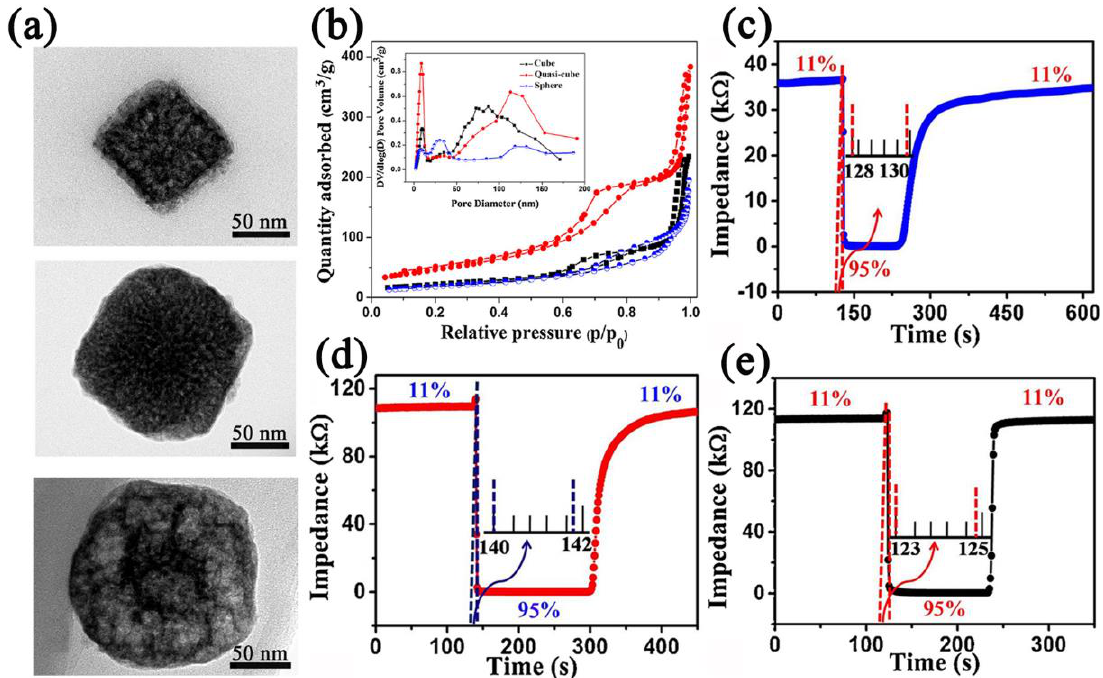
Figure 8. ( a ) TEM images of PB − derived Fe 2 O 3 nanostructures with different morphologies. ( b ) N 2 adsorption − desorption isotherms and corresponding pore size of different morphologies of Fe 2 O 3 nanostructures. Response and recovery curves of different morphologies of Fe 2 O 3 − based humidity sensors between 11% RH and 95% RH ( c ) cubes, ( d ) quasi − cubes, and ( e ) spheres. Reproduced with permission from Ref. [88]. Copyright 2019, Elsevier.